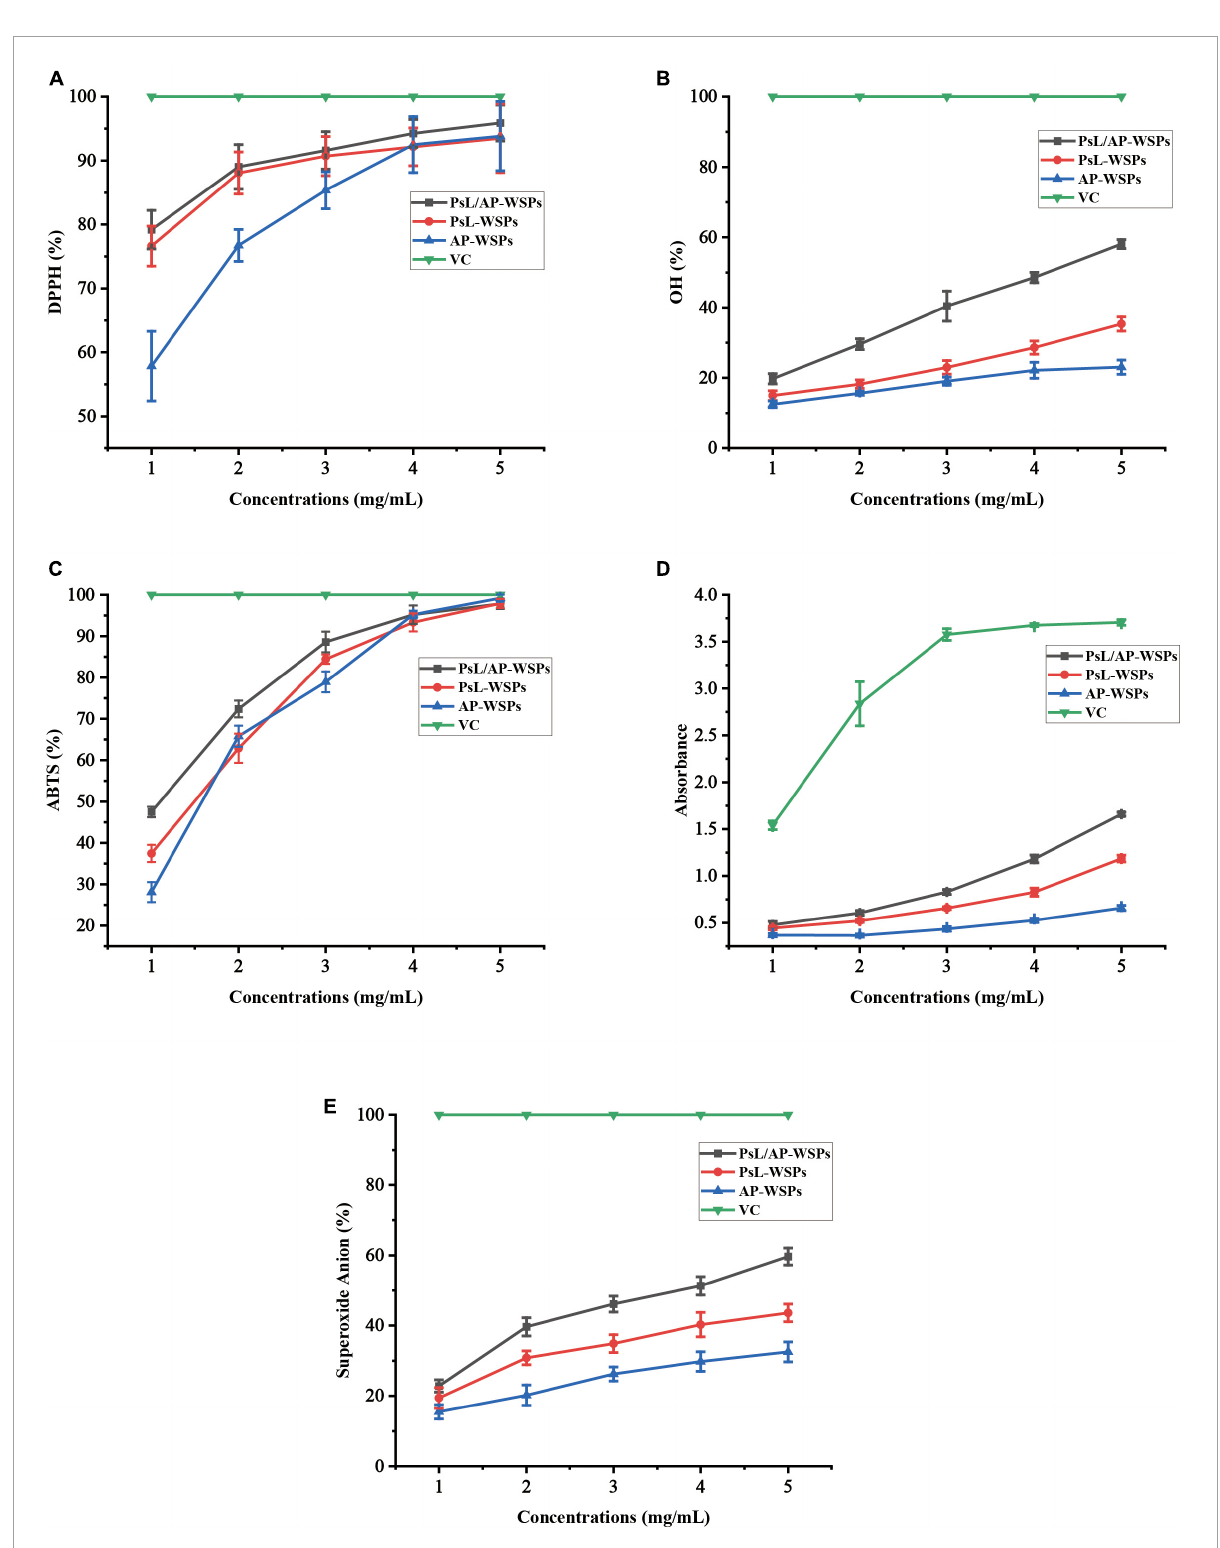
FIGURE5 Evaluation of antioxidant activities of WSPs. (A) DPPH radical scavenging ability, (B) OH radical scavenging ability, (C) ABTS radical scavenging ability, (D) ferric-reducing antioxidant power, and (E) superoxide anion scavenging